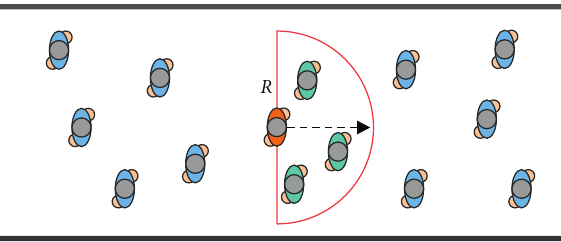
Figure 1: Schematic diagram of a pedestrian’s perception area. The red circle represents the subject pedestrian and green and blue circles represent neighboring pedestrians and other pedestrians in the flow, respectively. The red semicircle represents the perception area of the subject pedestrian with the radius of r